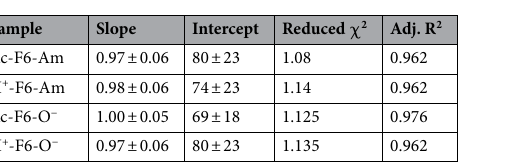
Figure 3. ( a ) Normalized PL spectra of the four F6 variants at λ exc = 330 nm. ( b ) Representative normalized fluorescence spectra of a peptide film (herein Ac-F6-Am is reported) versus the excitation wavelength in the range between 330 and 430 nm. Herein, the data were normalized with respect to the maximum of the emission spectrum and rescaled within the interval [0,1] in order to highlight the shift of the maxima position at increasing excitation wavelengths. ( c ) Plots of the maxima positions as function of the excitation wavelength of all peptides. Therein, the linear best-fit curves are also reported. ( d ) Excitation spectra of the F6 samples setting λ em = 400 nm (solid lines) and λ em = 450 nm (dash-dotted lines). The concentration of the samples was fixed at 5 mg/mL.